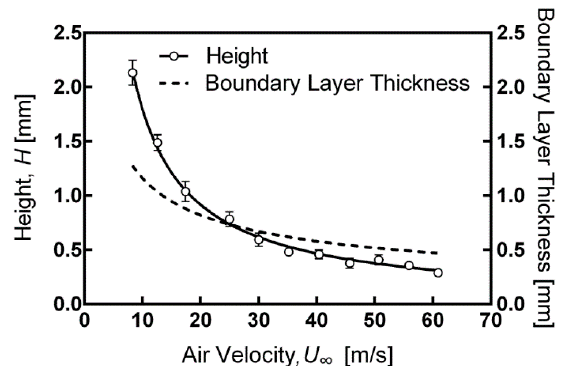
Figure 4. The critical droplet height related to the critical air velocity. This indicated that the correlation between the critical droplet height and air velocity was almost inversely proportional, shown as a solid fitted curve. The error bar of the height was given as the standard deviation. The dashed line is the numerically estimated boundary layer thickness by the Blasius exact solution [23]. The droplet is fully immersed in the boundary layer when U ∞ is greater than 30 m/s.